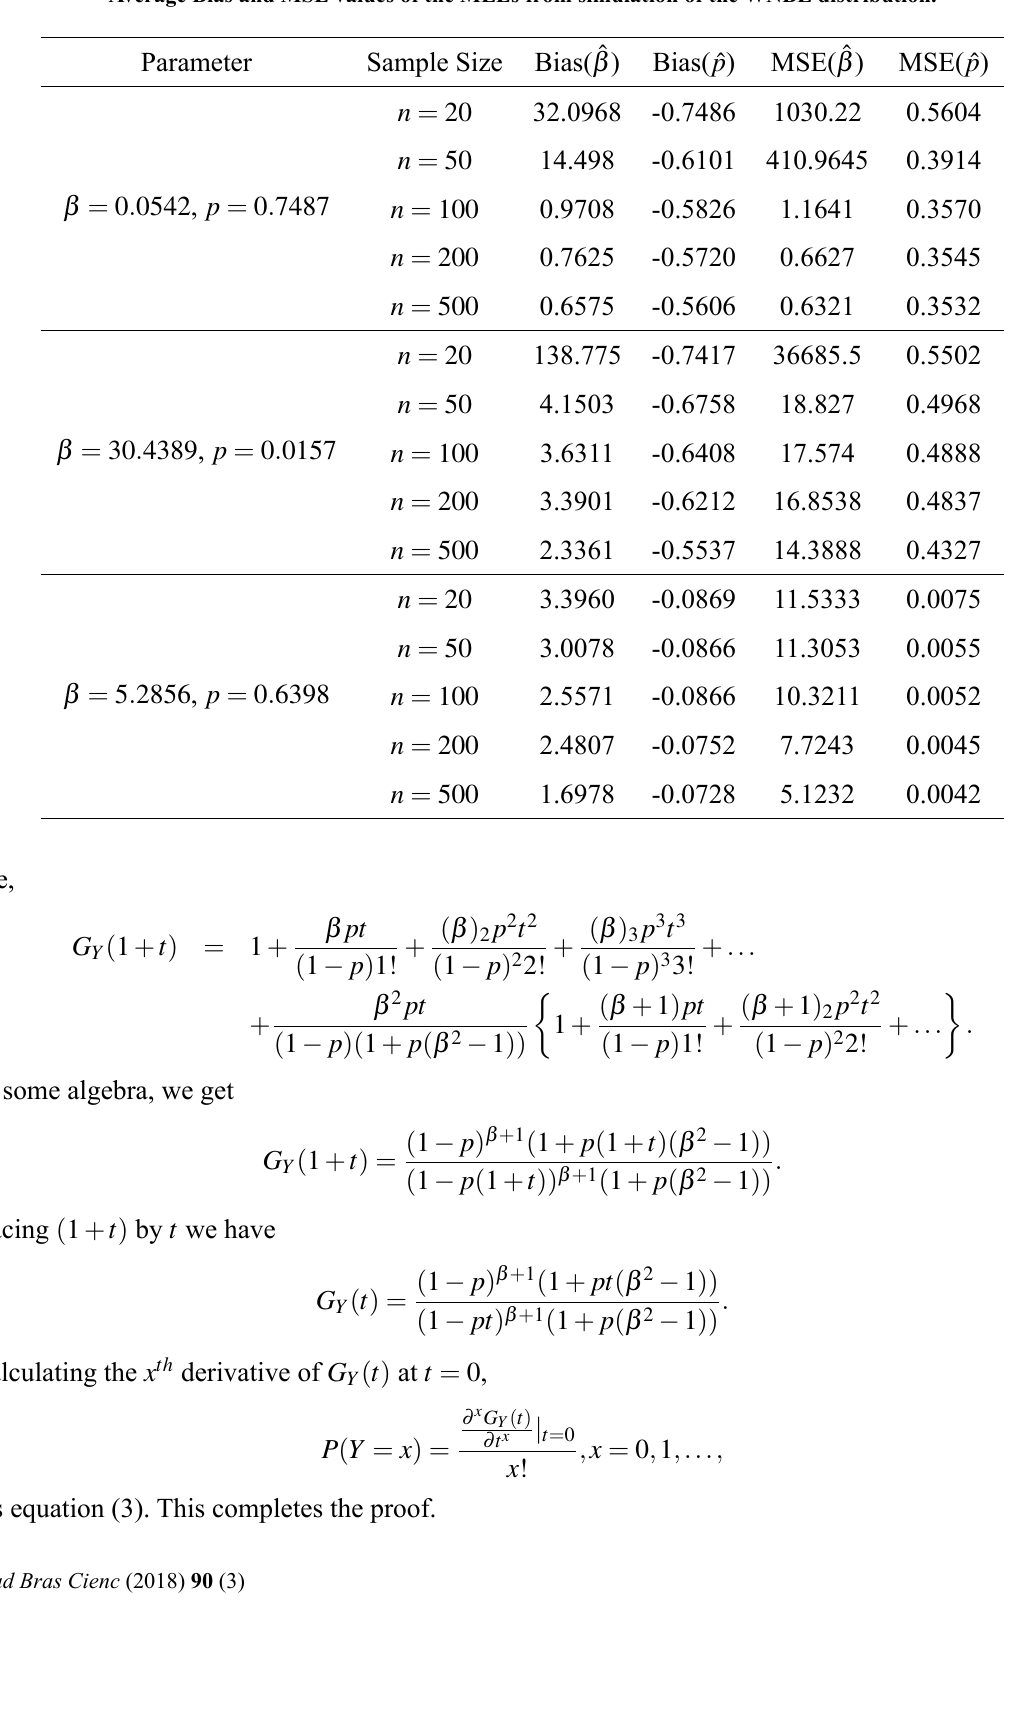
Average Bias and MSE values of the MLEs from simulation of the WNBL